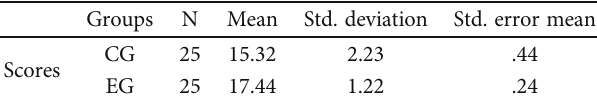
Table 3: Descriptive statistics of the idiom